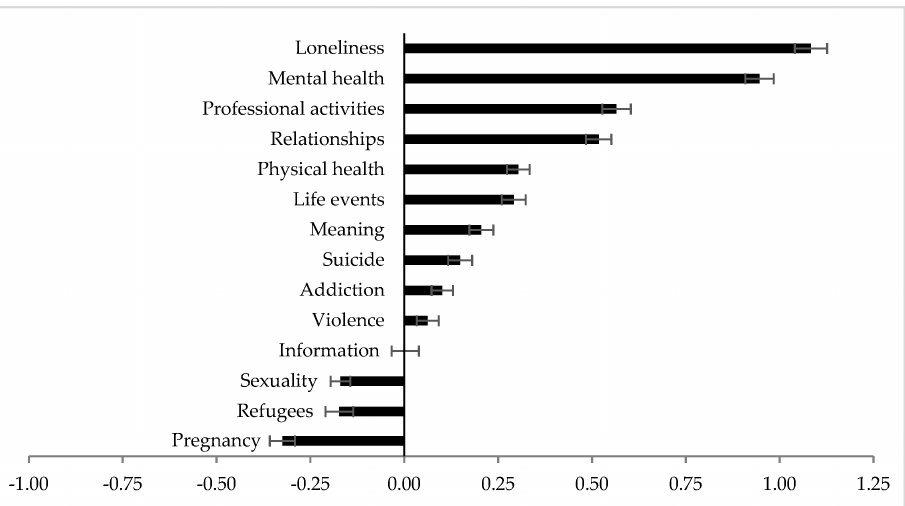
Figure 2. Rating of the change of the frequency of topics thematized by helpline callers during the COVID-19 pandemic as compared to the times before COVID-19 by Austrian counselors ( n = 336). Note: Counselors who already worked at the telephone emergency service before 2020 were asked to rate whether the frequency of the listed topics changed due to the COVID-19 pandemic on a five-point scale from − 2 = “significantly less” to 2 = “significantly more”, with 0 referring to “no change”. Data are shown as least square means (LSM) ± standard error of the